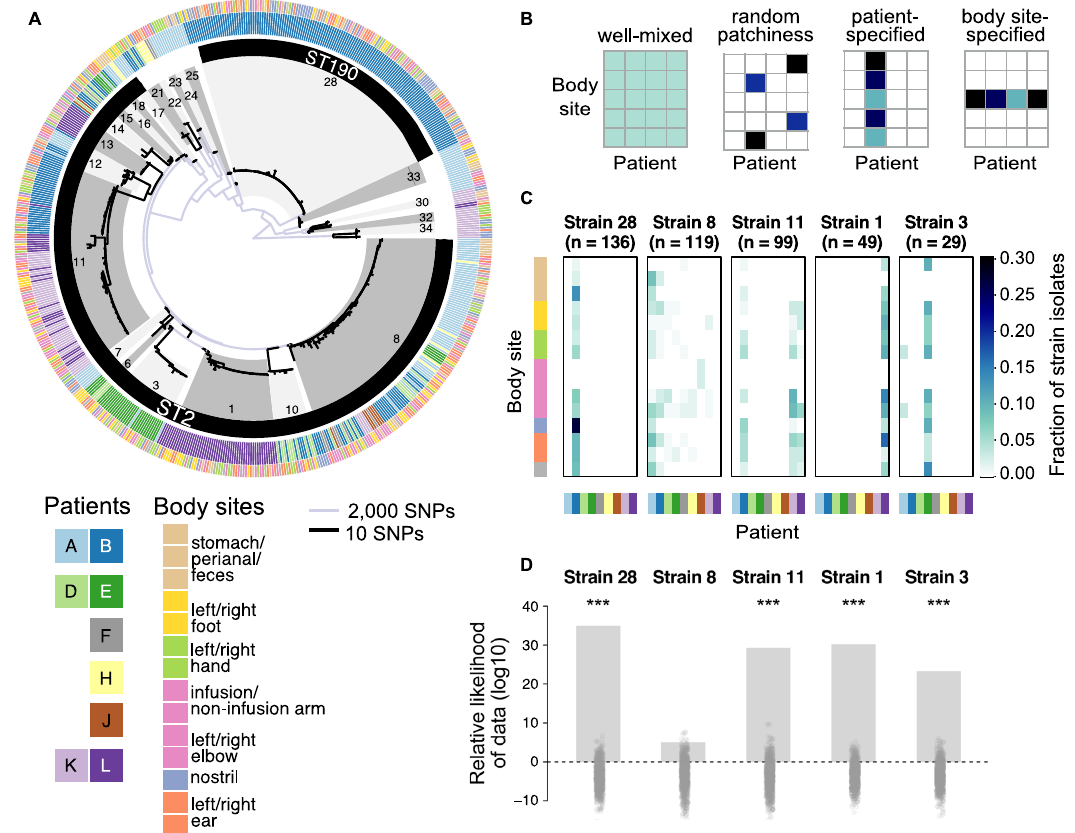
Fig. 2 Individual newborns are rapidly colonized by several distinct strains of S. epidermidis , which differ substantially in their colonization across patients, but are not body site-speci fi c. A Maximum-likelihood phylogeny based on single-nucleotide polymorphisms (SNPs). Individual strains are numbered and designated by alternating grayscale grouping (innermost ring). To depict SNP-level variation within strains (black branches), the scale for within-strain branches has been stretched by 200× compared to between-strain branches (light blue branches). Standard multi-locus sequence typing (MLST) indicates that the majority of strains can be grouped into ST2 or ST190 (black ring). The patient and body site from which isolates were collected are also indicated (outer rings). Twins are indicated by different shades of the same color. B Four possible models of strain colonization across patients and body sites. C Distributions of the fi ve most sampled strains across all patients. Color scale indicates the fraction of isolates for a given strain that was found on a particular patient/body site combination. D Relative log-likelihood (base 10) of strain distributions for each of the fi ve most sampled strains under a patient-only model versus a body site-only logistic regression model. Bars indicate the measured value of the relative log-likelihood for the data. Points indicate the values calculated for randomized strain distributions. *** p -value < 0.001. Source data are provided as a Source Data fi Fig. 2A and Supplementary Fig. 1, average pairwise between- strain SNP distance: 4208 ± 2352 SNPs). These results suggest that very early in life neonates are independently colonized by multiple coexisting strains.